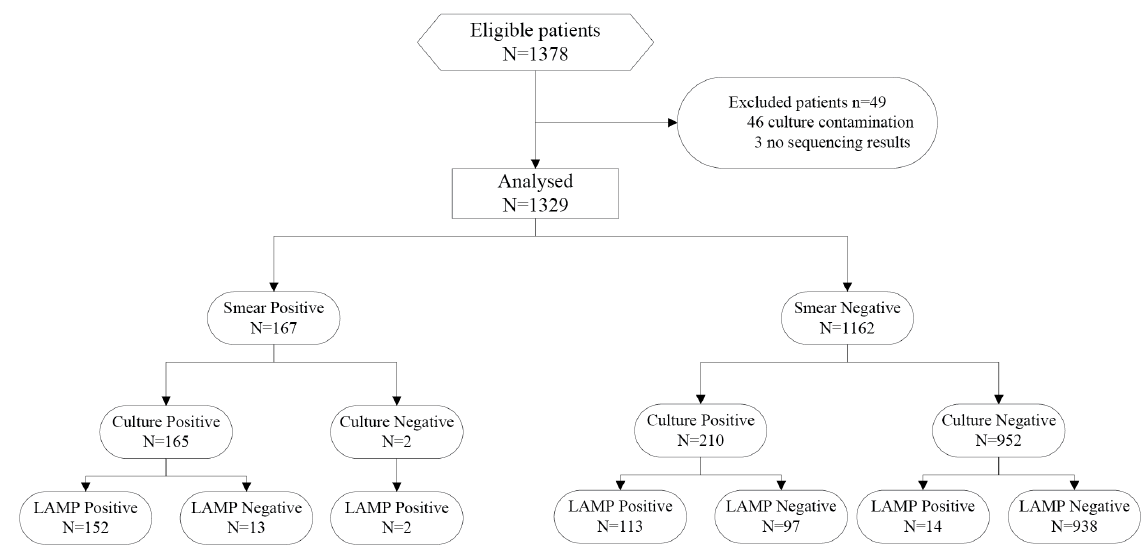
Figure 1. Patient enrollment and testing flow chart.